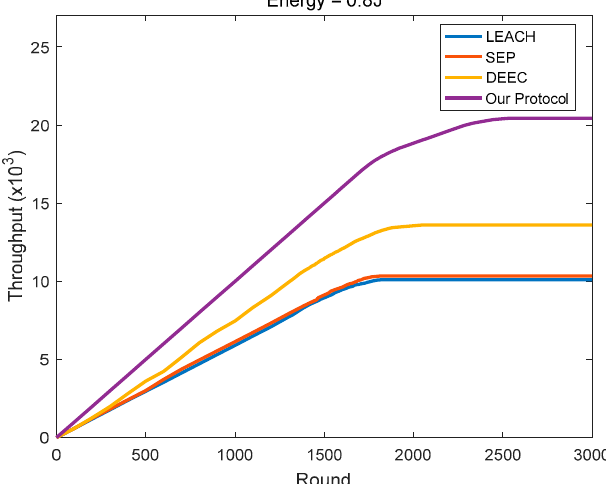
Sensors 2018 , 18 , x FOR PEER REVIEW 24 of 27 Figure 21. The network throughput varies with the round (initial energy = 0.8 J). Figure 21. The network throughput varies with the round (initial energy = 0.8 J). Figure 21. The network throughput varies with the round (initial energy = 0.8 J).